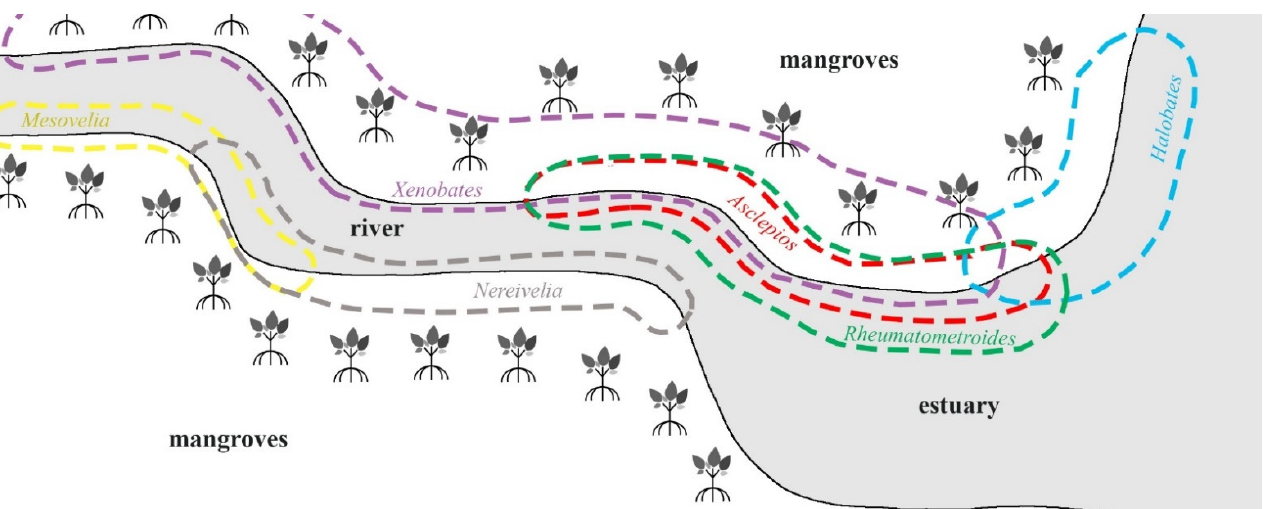
Table 2. Checklist of Gerromorpha taxa found in this study.